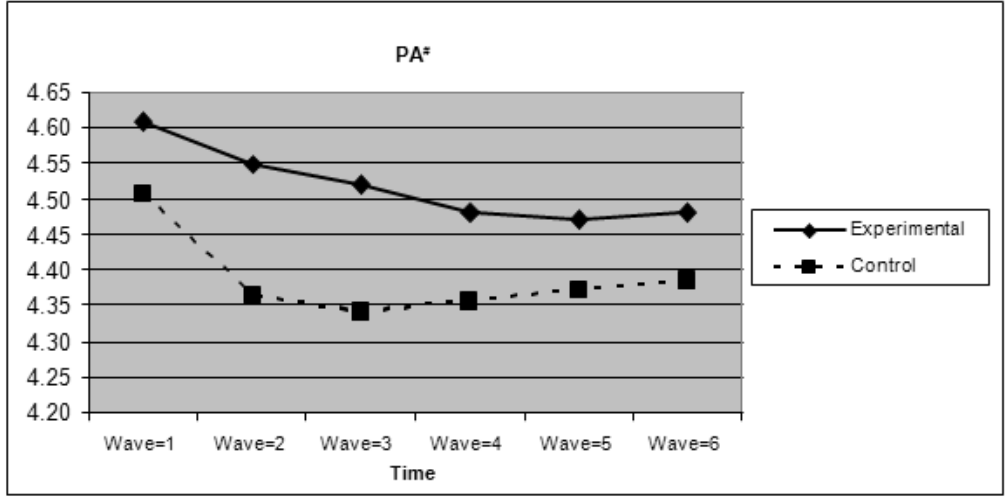
FIGURE 7. Growth trajectories of the experimental participants Δ and control participants using PA # as an outcome indicator. Δ Experimental participants who regarded the program as beneficial. # Prosocial attributes second-order factor.